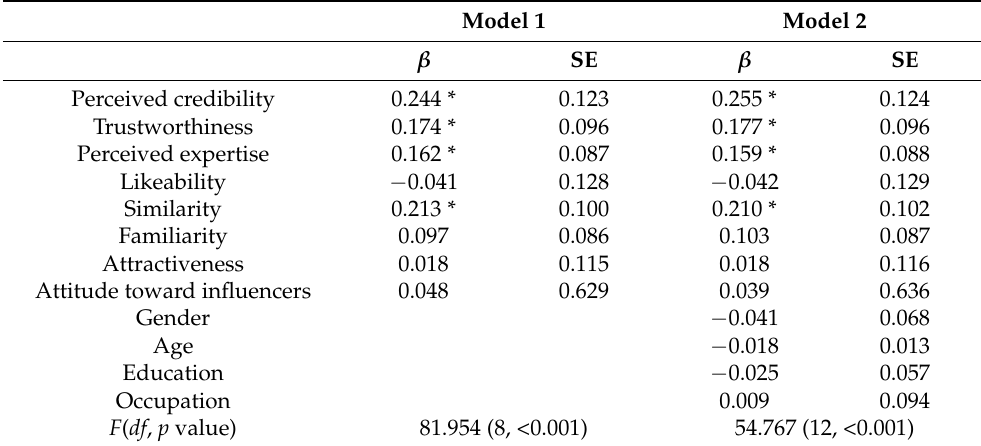
Table 5. Multivariate regression analyses assessing the association of the independent variables and sociodemographic variables with purchase